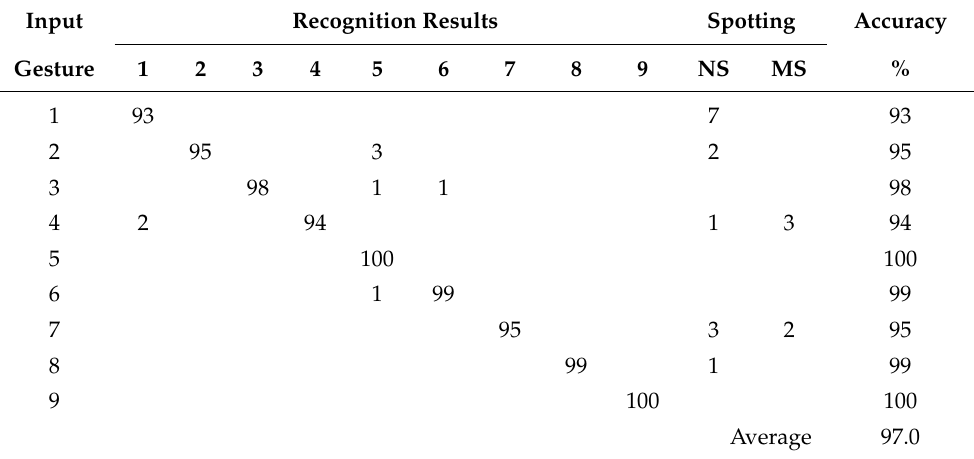
Table 3. Confusion table (10